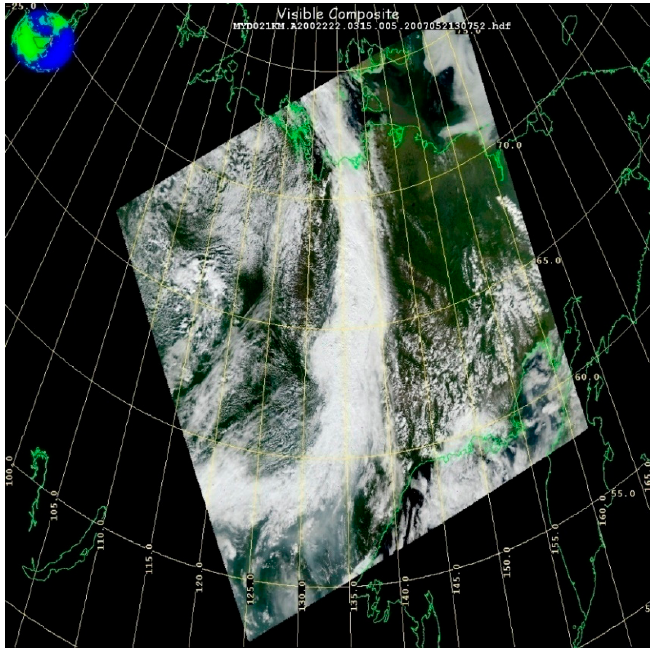
Figure 7. MODIS/Aqua true color image at 0315 UTC on 10 August 2002 (image downloaded from https://ladsweb.modaps.eosdis.nasa.gov/).